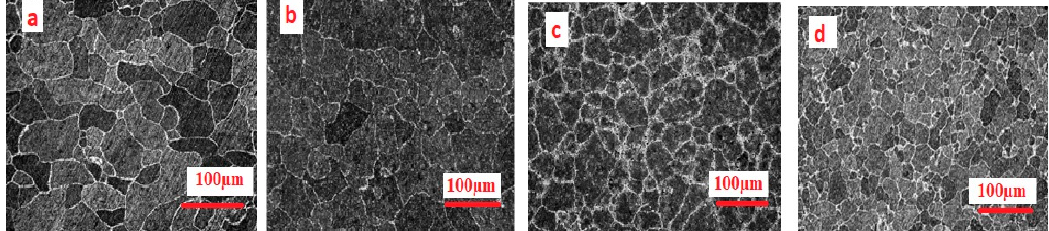
Figure 2. Al5083 alloy microstructure: ( a ) annealed; ECAP after the ( b ) first, ( c ) second, and ( d ) third passes.